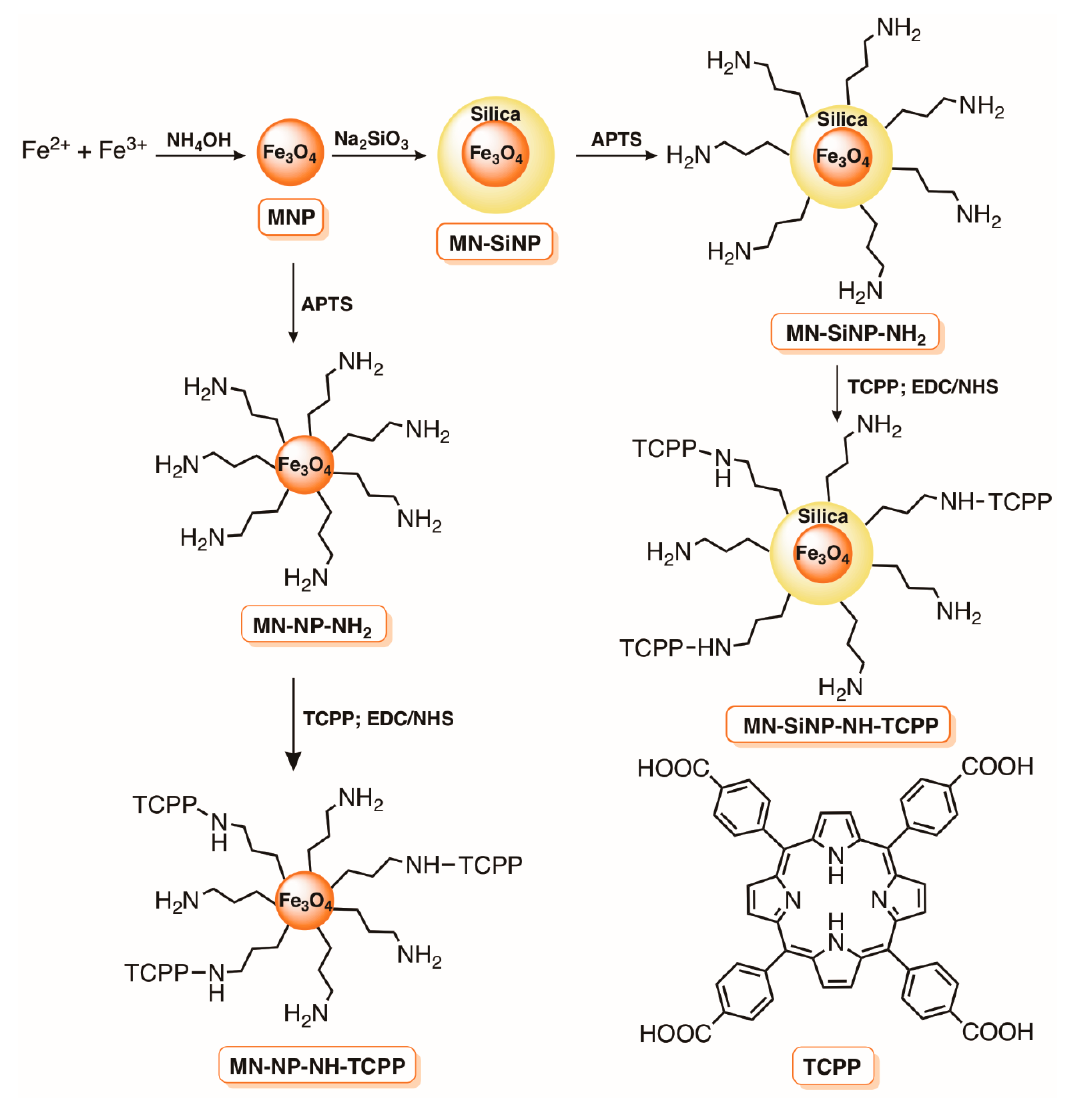
Figure 11. Representation of the synthetic access to nanomagnet materials MN-SiNP-NH-TCPP and MN-NP-NH-TCPP (adapted from Reference [98]).